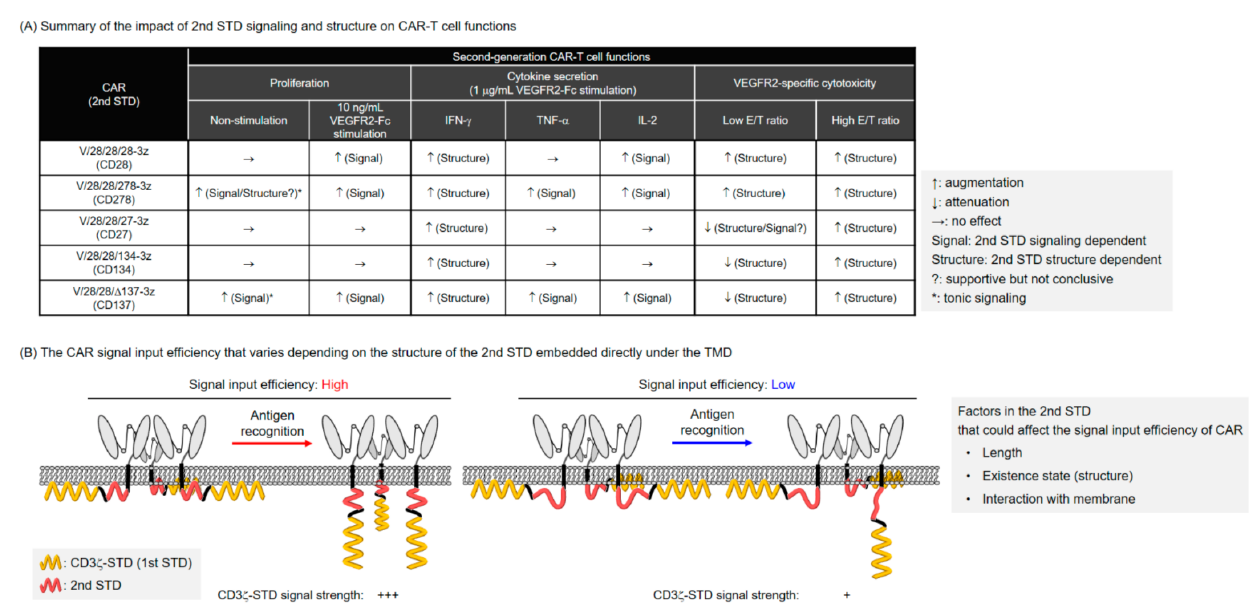
Figure 5. The effects of 2nd STD signaling and structure on the functions of second-generation CAR-T cells. ( A ) The table shows the effect of second-generation CARs inserted directly below the TMD with various co-stimulatory molecule-derived 2nd STD on T cell functions. Arrows indicate increases or decreases in T cell functions when compared to first-generation CAR, and in parentheses, whether these increases or decreases are due to the signal or structure of the 2nd STD. Question marks are assigned if they cannot be definitively attributed to the structure or signal of the 2nd STD. ( B ) The illustration shows that the signal input efficiency of CAR is altered by the 2nd STD structure revealed by this study. Based on the structure of the second-generation CARs used in this study, we speculated that the length and existence state (structure) of the STD and its interaction with the cell membrane may be factors that define the CAR signal input efficiency. The “+” in the figure indicates the strength (input amount) of the CD3 ζ − STD